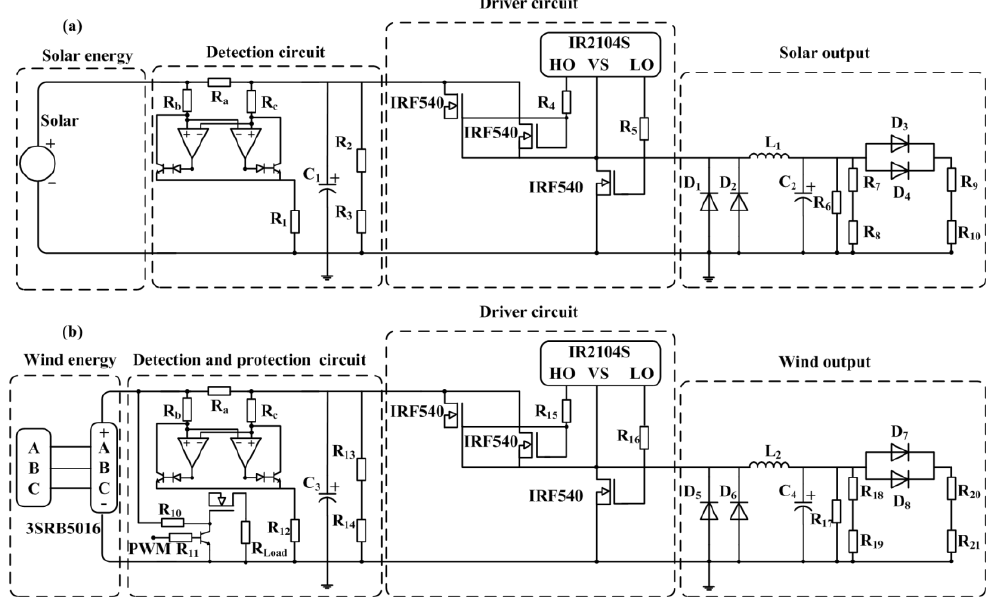
Figure 10. Schematic of the solar circuit ( a ) and SWT charging circuit ( b ).